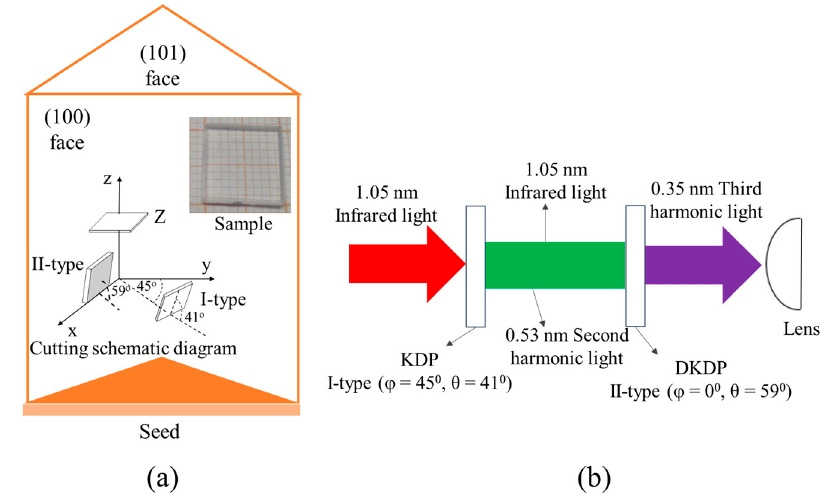
Figure 2. ( a ) Cutting schematic diagram of samples with different directions; ( b ) The mechanism diagram for KDP/DKDP crystals in Inertial Confinement Nuclear Fusion (ICF).